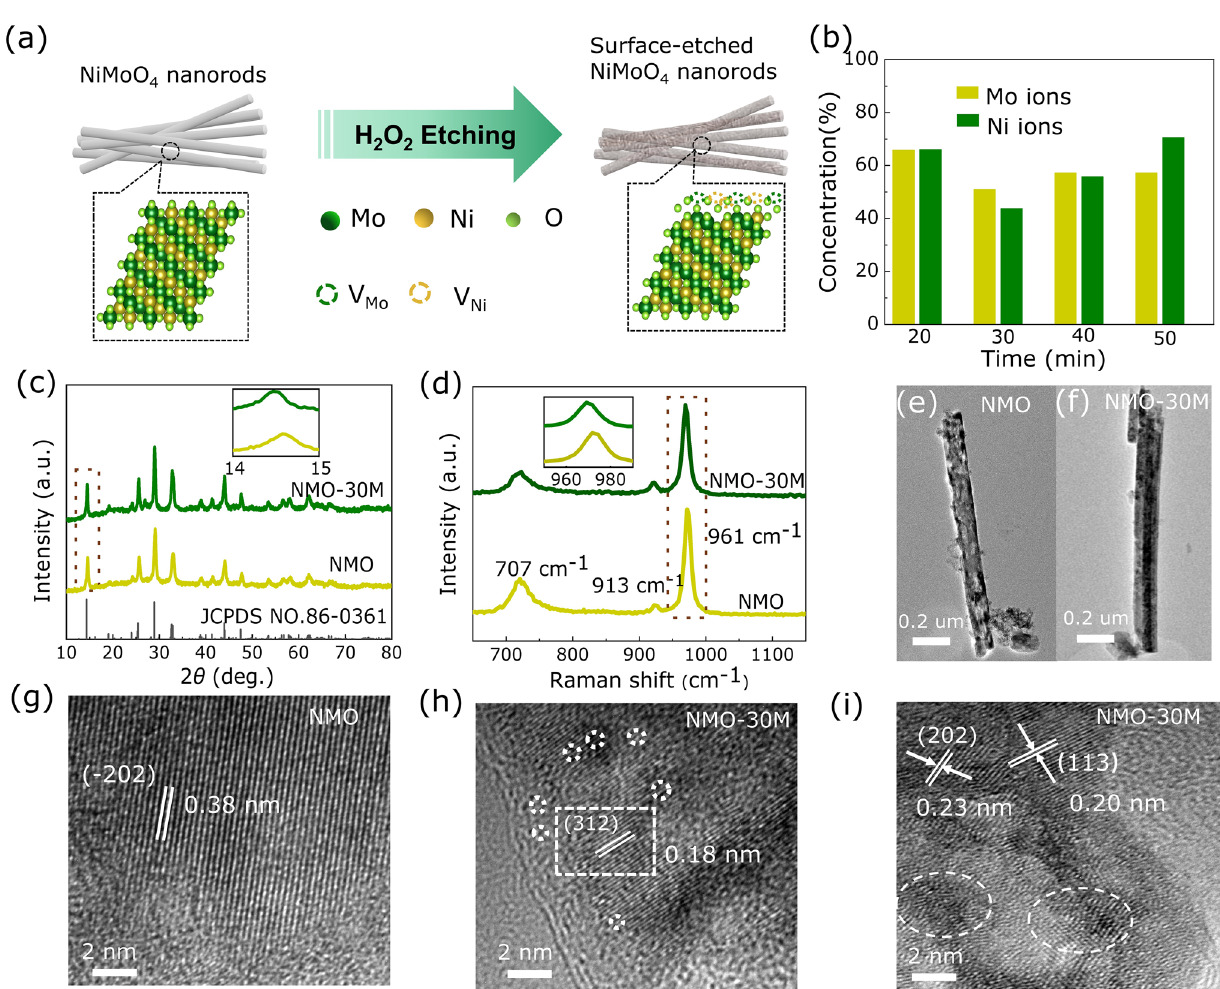
Fig. 1 Structure, morphology and phase composition of catalysts. a Diagram of synthesis process for NMO-30M and NMO-50M. b Contents of Ni and Mo in the supernatant after etching of NiMoO 4 (plotted from ICP results). c XRD pattern and d Raman spectra of as-prepared NMO and NMO-30M. The insets are the zoomed images of for XRD and Raman, respectively. The TEM images of e NMO and f NMO-30M. High- resolution TEM images of g NMO and h , i